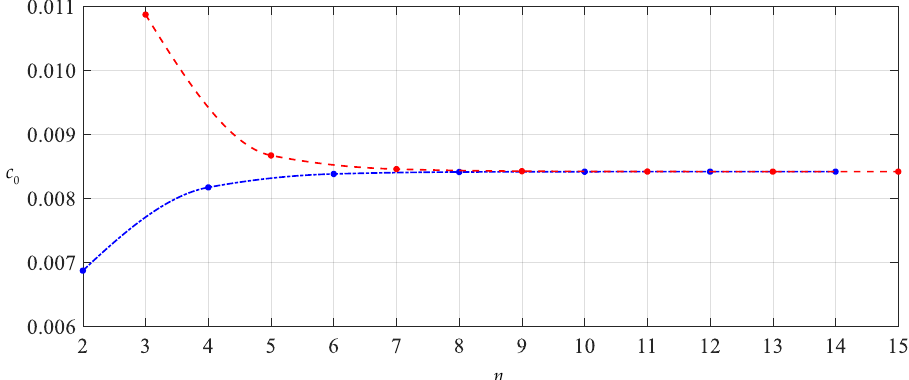
Figure 4. Variation of c 0 with n .